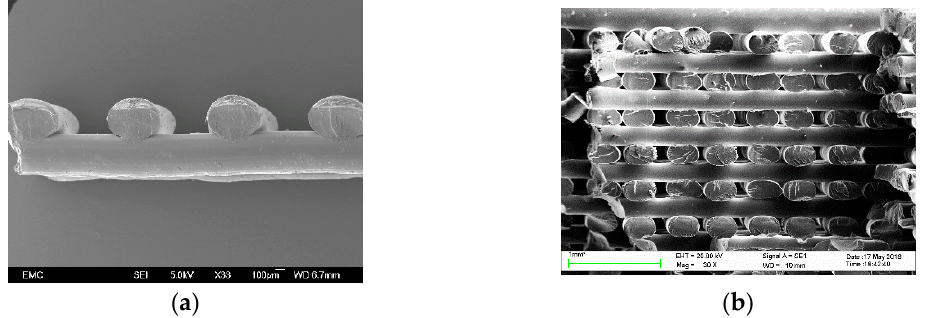
Figure 2. SEM images of FFF parts showing: ( a ) the cross-sectional area of extruded filaments in a two layers array; and ( b ) stacking of several layers.